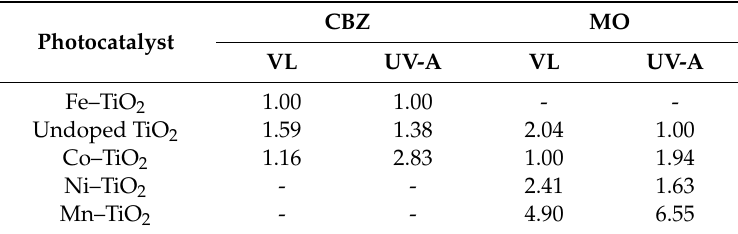
Table 1. Functional unit based on photocatalytic activity for each pollutant under study. “-” refers to cases in which the photocatalysts were not